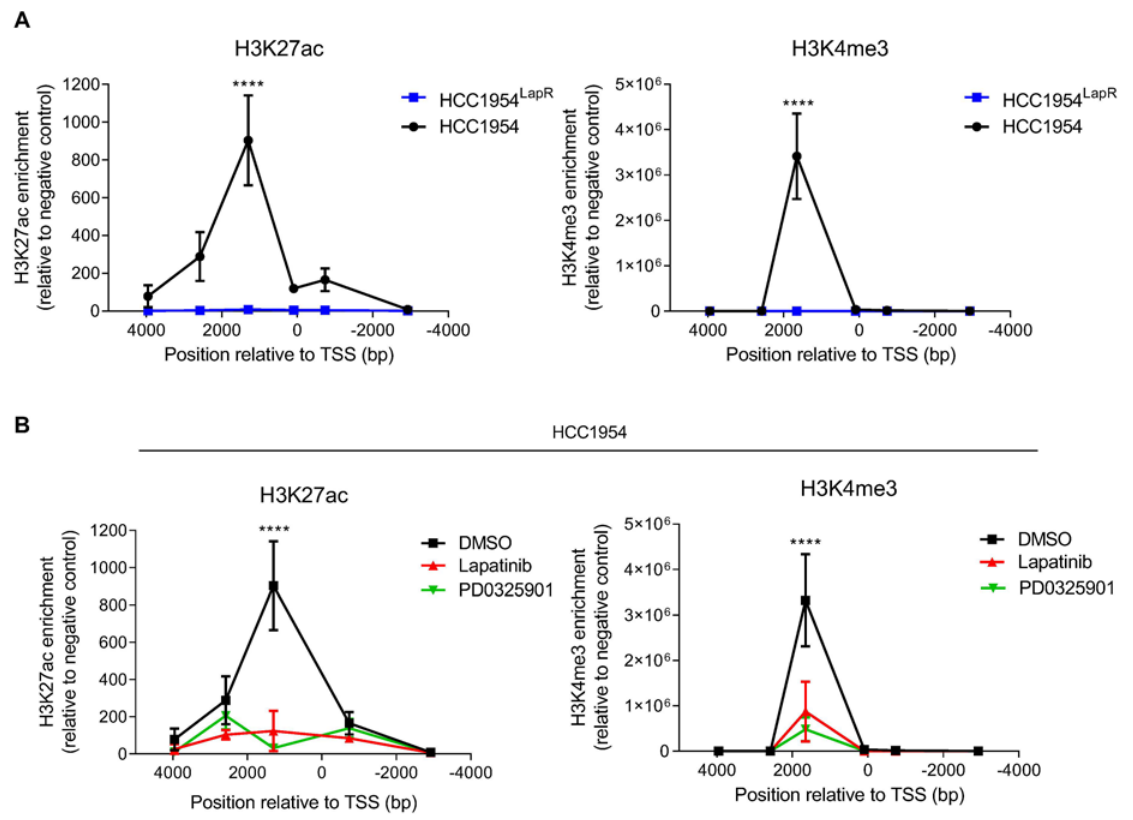
Figure 3. PHLDA1 downregulation is associated with epigenetic changes at the PHLDA1 locus. ( A ) ChIP-PCR analysis of H3K27ac ( left ) and H3K4me3 ( right ) deposition at the PHLDA1 locus in HCC1954 and HCC1954 LapR cells. ( B ) HCC1954 cells were treated with 1 µ M lapatinib or 200 nM PD0325901 or DMSO for 72 h before H3K27ac ( left ) and H3K4me3 ( right ) at the PHLDA1 locus was analysed by ChIP-PCR. Data are presented as mean ± SEM of three independent experiments. **** p < 0.0001. Two-way ANOVA with multiple comparison